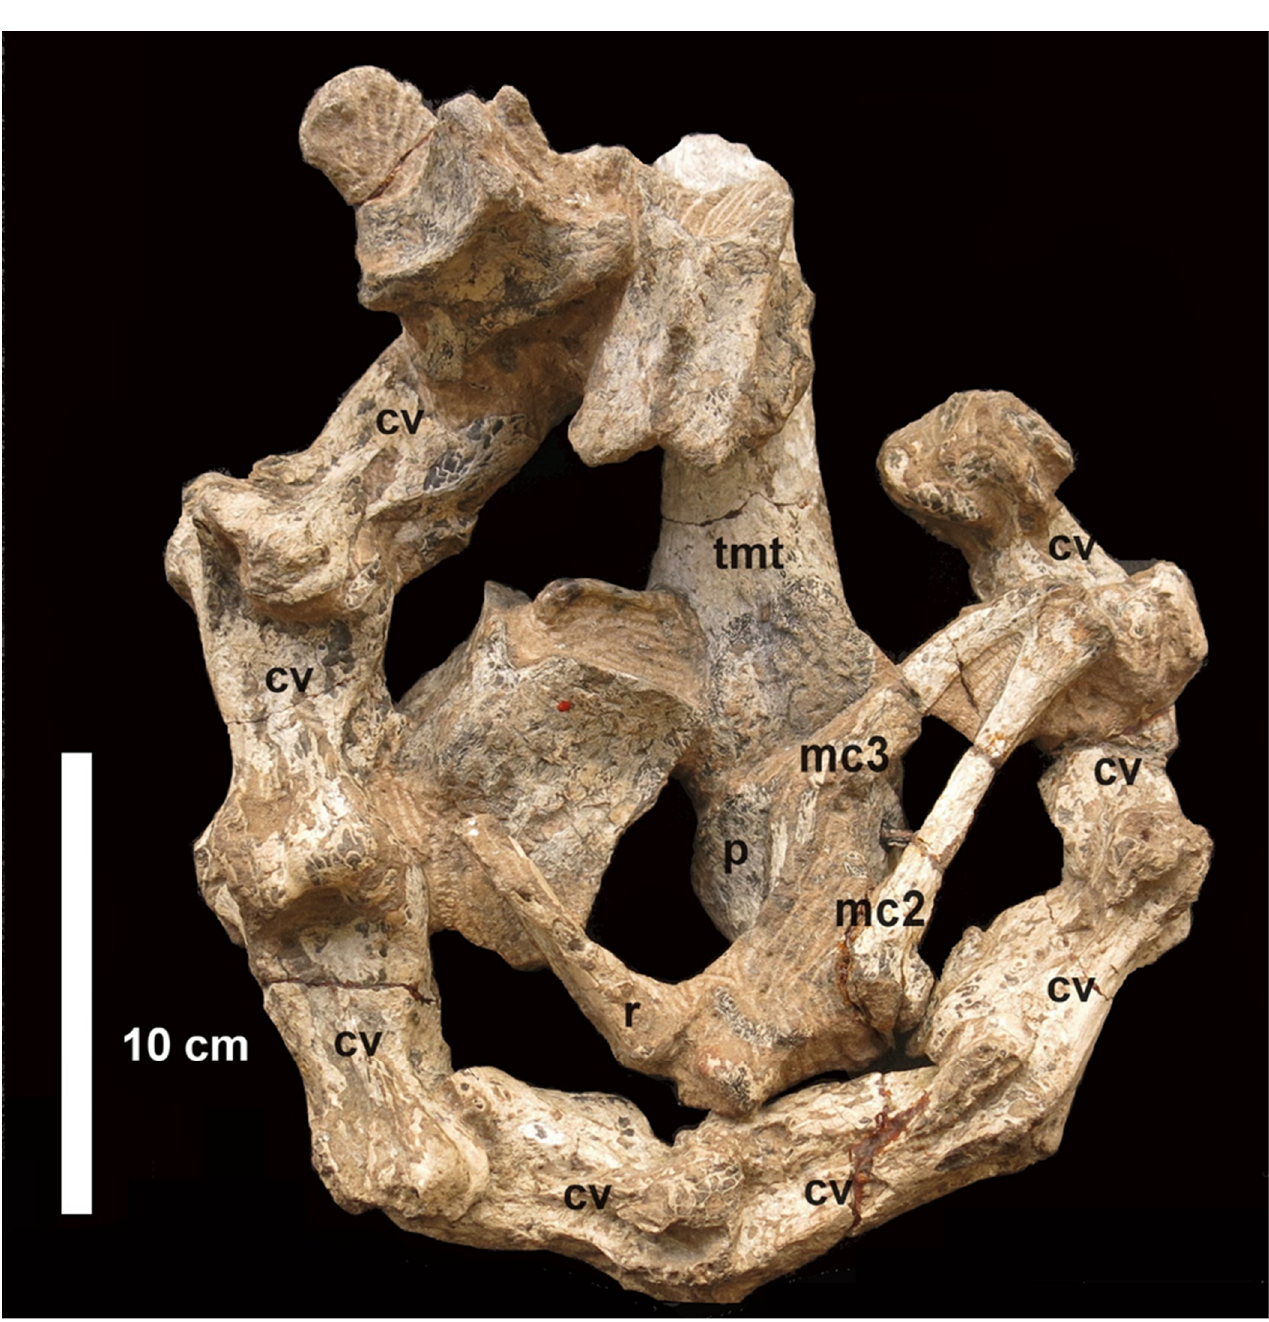
Figure 2. Type specimen of Struthio asiaticus Milne-Edwards, 1869–1871, NHMUK PV OR 23105, with the tarsometatarsus in caudal view, showing the series of caudal vertebrae and bones of the forelimb; cv: cervical vertebrae; mc2: second metacarpal; mc3: third metacarpal; p: first phalanx of third toe; r: distal end of radius (?); tmt: tarsometatarsus. A series of ten articulated cervical vertebrae forms a semi-circle around the limb elements. The two vertebrae at the ends of the series are incomplete. Two additional cervicals are not articulated with the rest. The vertebrae are not very well preserved and show few details (Figure 3), but their approximate position in the vertebral column can be estimated. By comparison with the cervical series of Struthio camelus [27], they probably correspond to the middle to posterior section of the neck (5th to 14th according to Davies [3]). They generally resemble vertebrae of the living Struthio (Figure 3), although Davies [3] noted some differences in proportions (see below).